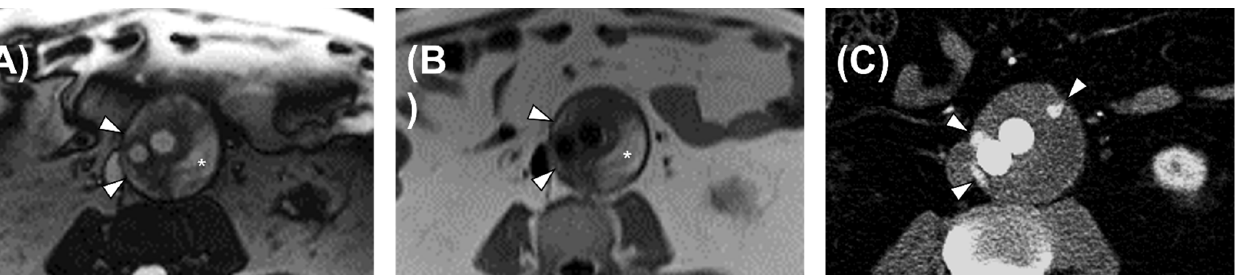
Figure 1. An example of a true ‐ positive case, a 68 ‐ year ‐ old male patient. ( A ) True ‐ FISP sequence: the white arrowheads indicate hyperintensities related to the endoleak, whereas * denotes the hyperintensity of the blood clot in the aneurysmatic sac. ( B ) HASTE sequence: the white arrowheads indicate hyperintensities related to the endoleak, whereas * denotes the hyperintensity of the blood clot in the aneurysmatic sac. ( C ) CTA: arterial phase acquisition. The arrowheads indicate three hyperdense areas suggesting endoleak, one of which is not clearly visible in the RM images.